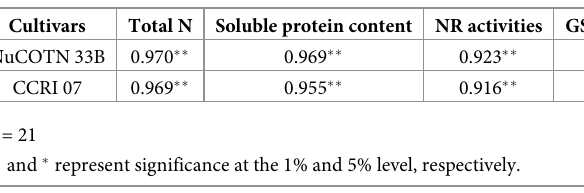
Table 7. Correlation coefficients between physiological indexes and Bt protein content in cotton squares under soil salinity stress in 2017. Cultivars